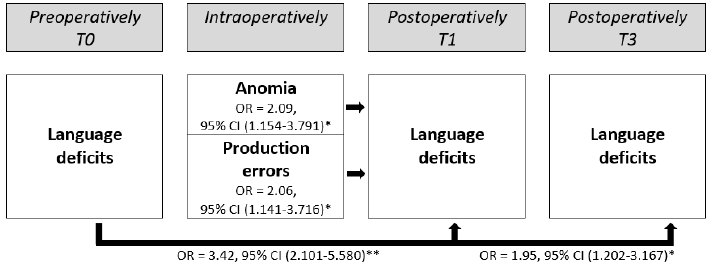
Figure 3. Significant preoperative and intraoperative predictors for postoperative language deficits at T1 ( n = 589) and T3 ( n = 456). T0 = preoperatively and postoperatively, T1 = 1–10 days, T3 = ≥ 3–8 months, OR = odds ratio and CI = confidence interval. This figure describes the binary logistic regression (T1 and T3) with the predictors of preoperative language status, intraoperative speech and language error categories, where the dependent variable is postoperative language outcome and reference categories are no preoperative language deficits and intraoperative speech arrest. * = p < 0.05. ** = p < 0.001.